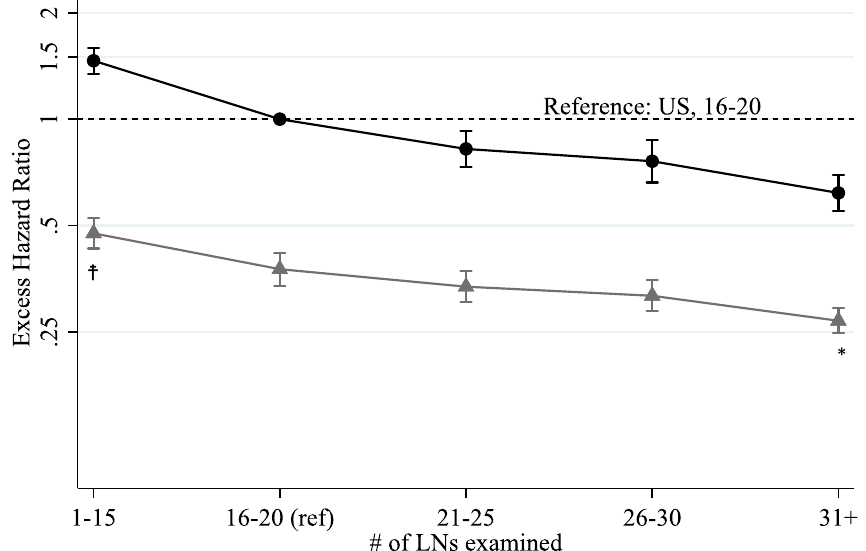
Figure 1. The excess hazard ratios of interaction between number of LN examined and country (Japan); Reference: United States and #LN examined 16 – 20, including all non-metastasis cases, Black dots: United States and Gray triangles: Japan, is statistically signi fi cantly lower EHR than 1 of the interaction of Japan, and * is statistically signi fi cantly higher EHR than 1 of the interaction of Japan, Black and gray bar lines: 95% CI and statistical signi fi cance criterion is 5%. CI, con fi dence interval; EHR, excess hazard ratio; LN, lymph nodes.